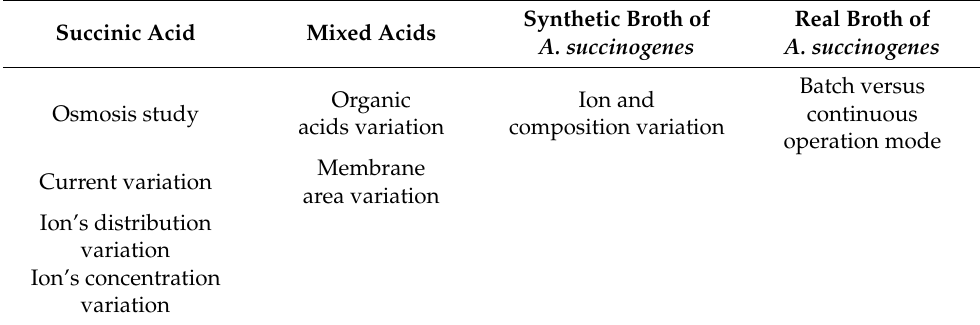
Table 2. Type of experiments performed with different organic acid and broth